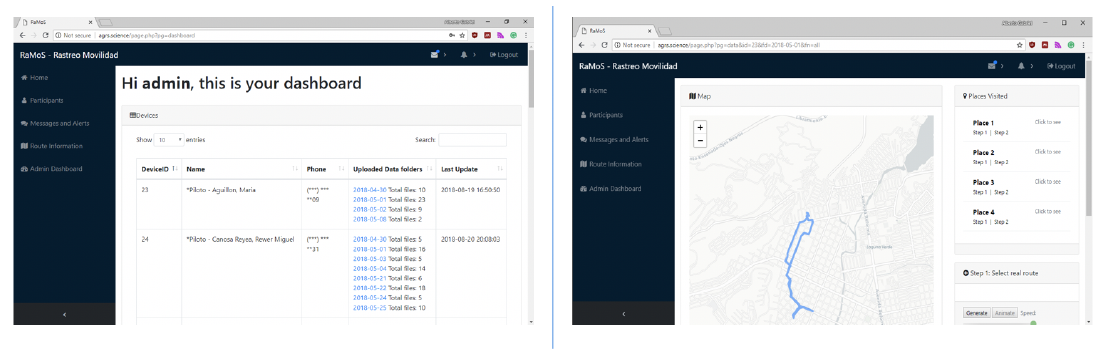
Figure 4. Administrative tools on the server side include a dashboard to manage devices, campaigns and users, as well as data visualization and analysis